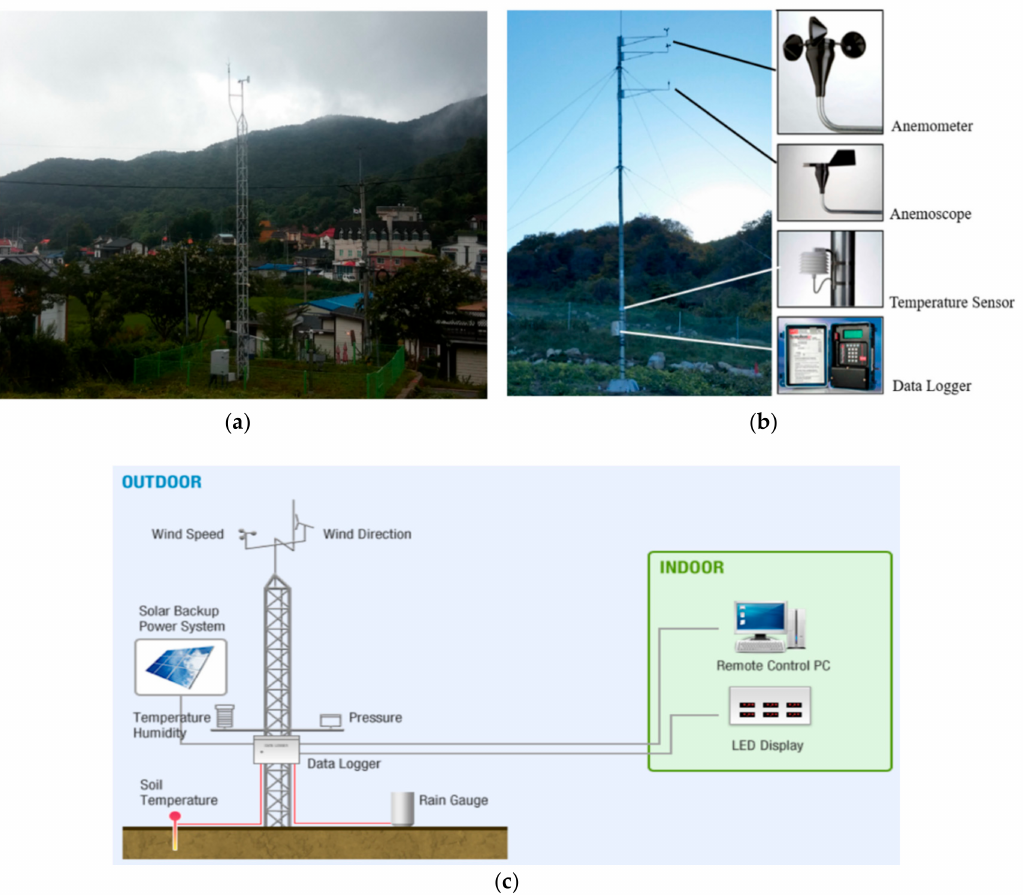
Figure 2. Wind data measuring apparatuses at both sites ( a ) Reference site; ( b ) Test site; ( c ) Automatic weather systems (AWS) data collection process